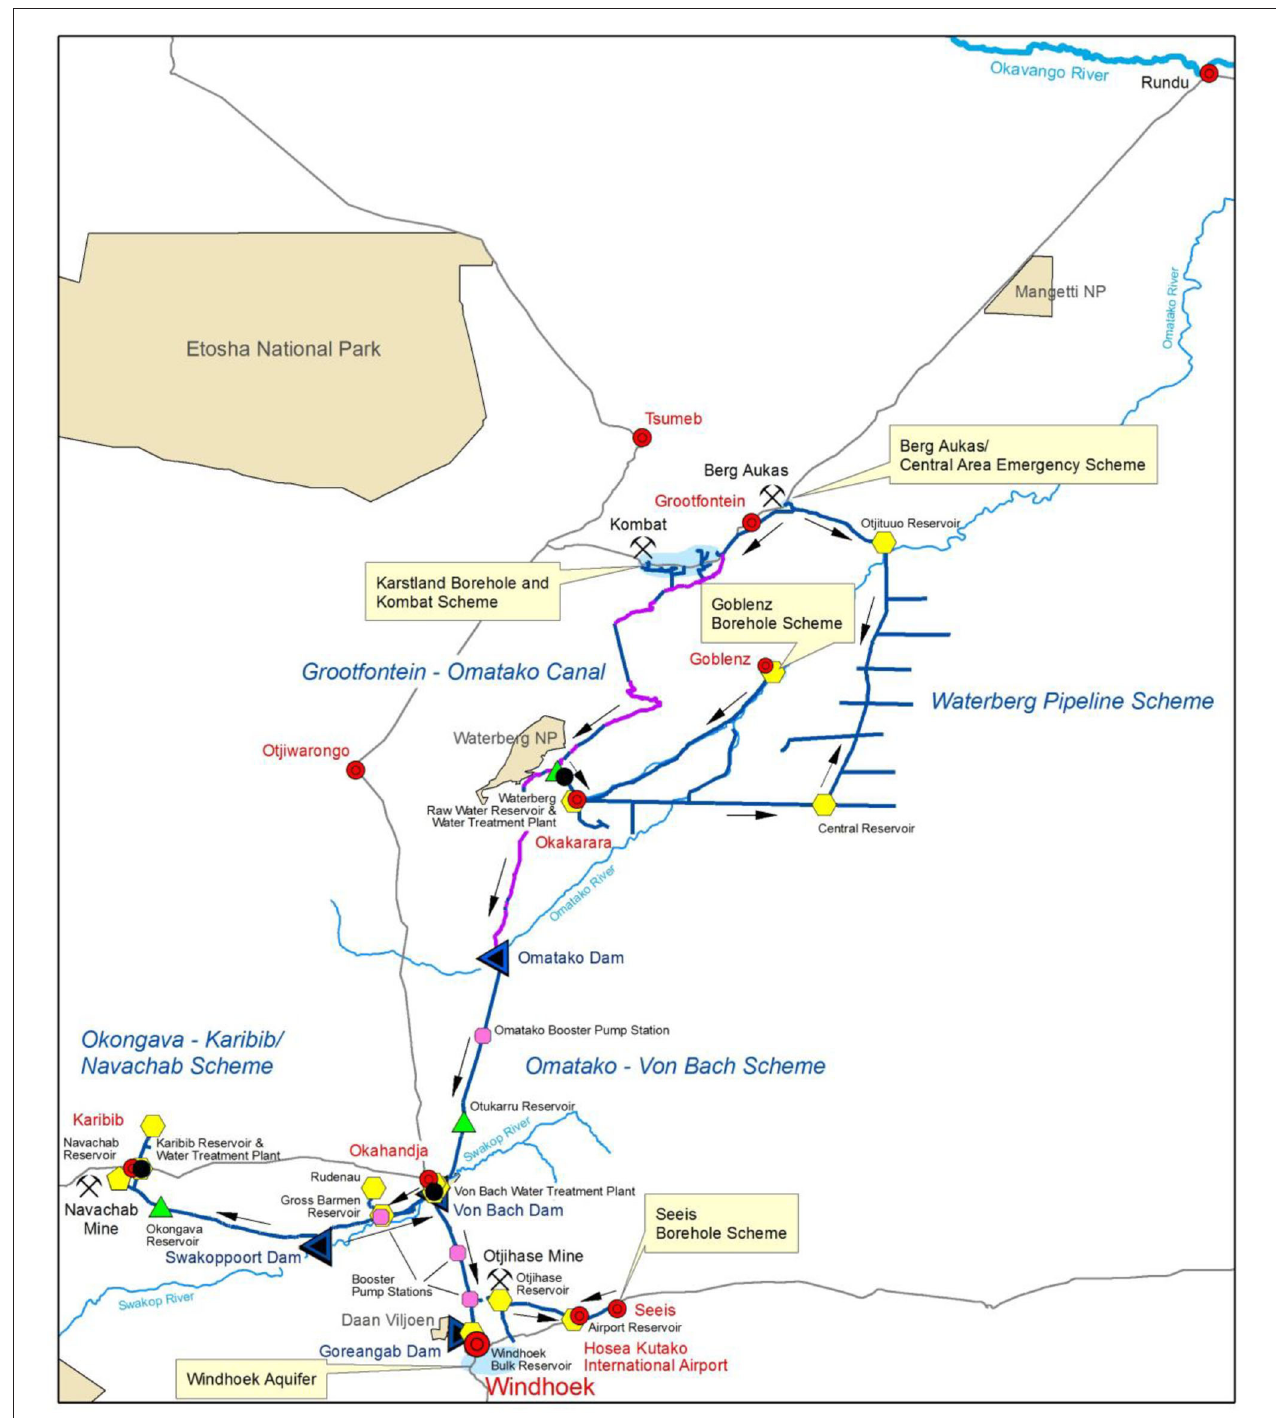
FIGURE 2 | Layout of the bulk water supply infrastructure in the Central Area of Namibia (Bruce and Burger, 2019).